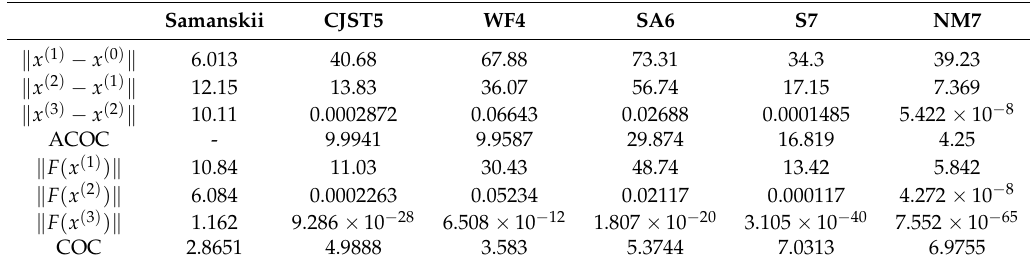
Table 6. Numerical results for Example 4.